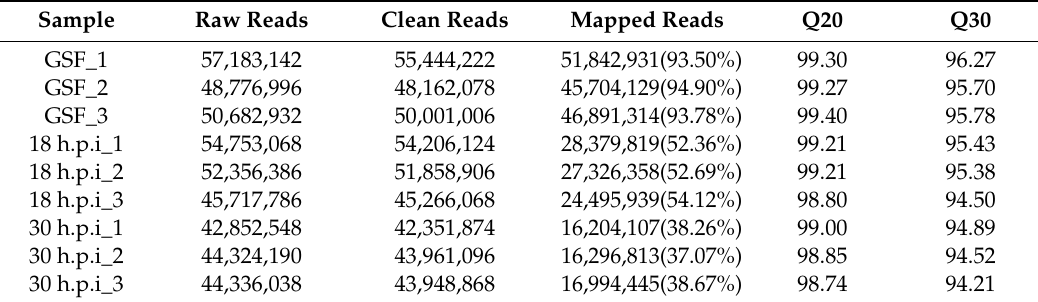
Table 1. Statistics of raw and clean reads from each sample.